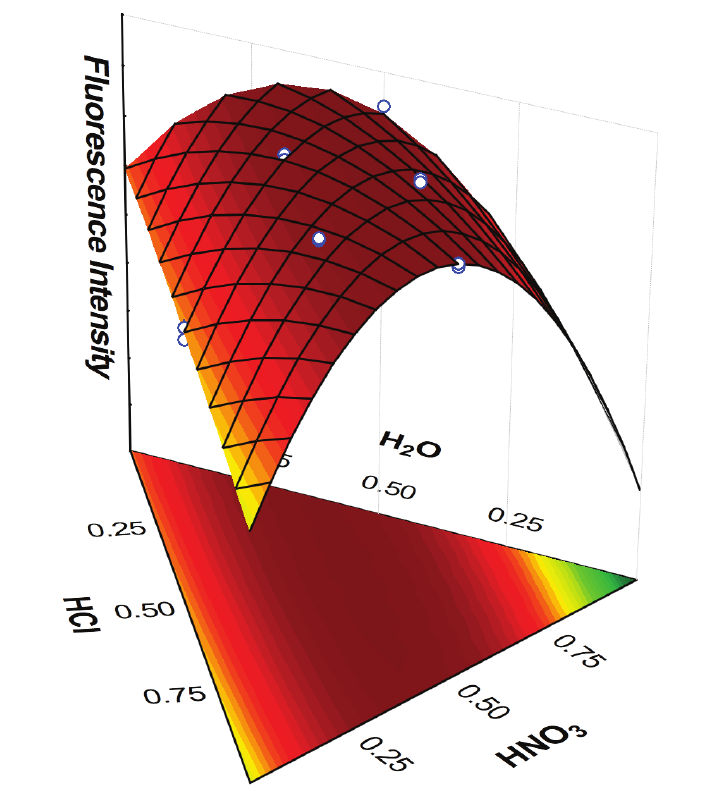
Figure 3 - Response surfaces for quadratic functions adjusted to the antimony fluorescence signal obtained after microwave digestion in pressurized pumps of hair